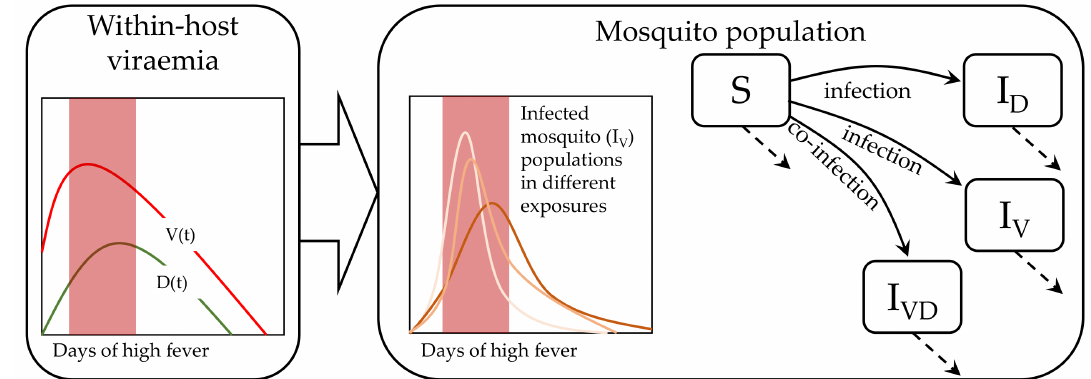
Figure 1. Dengue virus host-to-vector transmission model: the virus ( V ( t ) ) and the defective interfering (DI) particles ( D ( t ) ) are transmitted from infected hosts to mosquitoes. The susceptible mosquitoes ( S ) can be infected by virus or DI particles to generate the two types of infected mosquitoes, I V and I D . Further, a dually-infected population ( I VD ) is generated from co-infection by D ( t ) and V ( t ) , simultaneously. The model has been considered in two-compartments. The D ( t ) and V ( t ) are generated in the within-host compartment and infect the mosquito population in the other compartment. For each within-host model (shown in left box), multiple plausible transmission models has been calibrated (shown by multiple lines). The shaded domain indicates the days of high